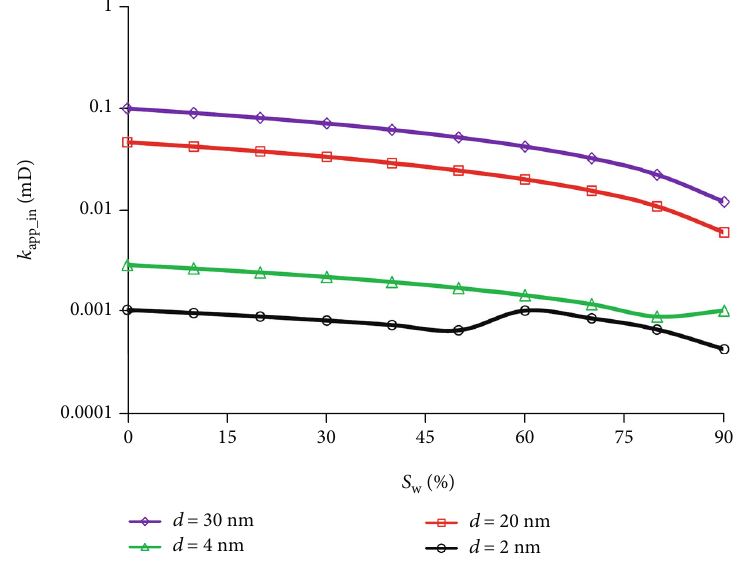
Figure 11: Gas permeability at di ff erent water saturations for di ff erent pore